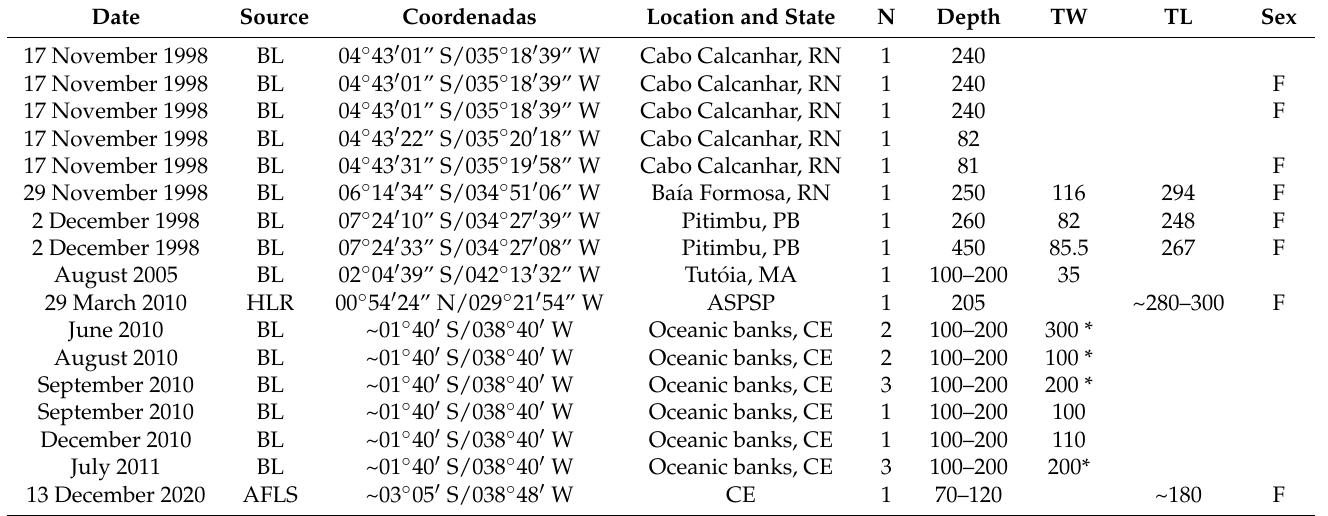
Table 1. Information on the Hexanchus griseus specimens recorded in the Tropical Southwestern Atlantic from 1998 to 2020. Bottom longline, BL; artisanal fishing landing site, AFLS; handline using line reels, HLR; Maranh ã o, MA; Cear á , CE; Rio Grande do Norte, RN; Para í ba, PB; Saint Peter and Saint Paul Archipelago, ASPSP. N, number of specimens; TW, total weight in kg; TL, Total length in